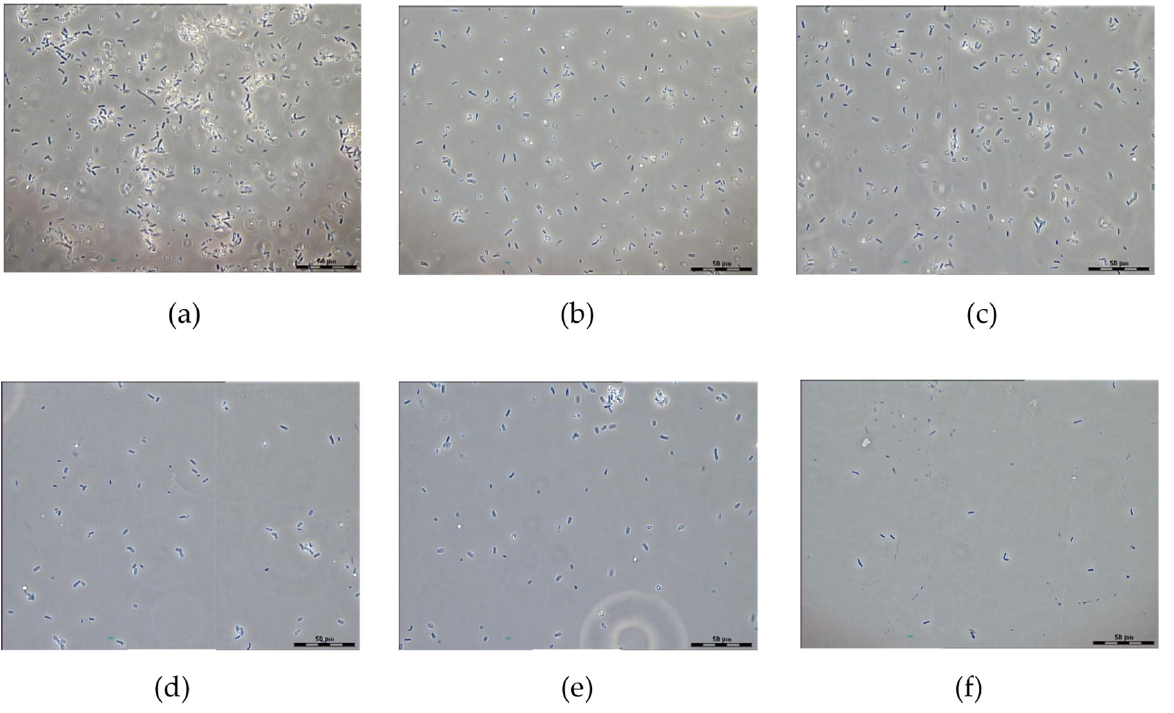
Figure 6. The laser dissector images of E. coli K-12 before ( a ) and after the CAP treatment with the different concentrations ( μ g/mL): ( b )—0.5; ( c )—2.5; ( d )—5; ( e )—10; ( f )—15. Scale bar is 50 μ m.